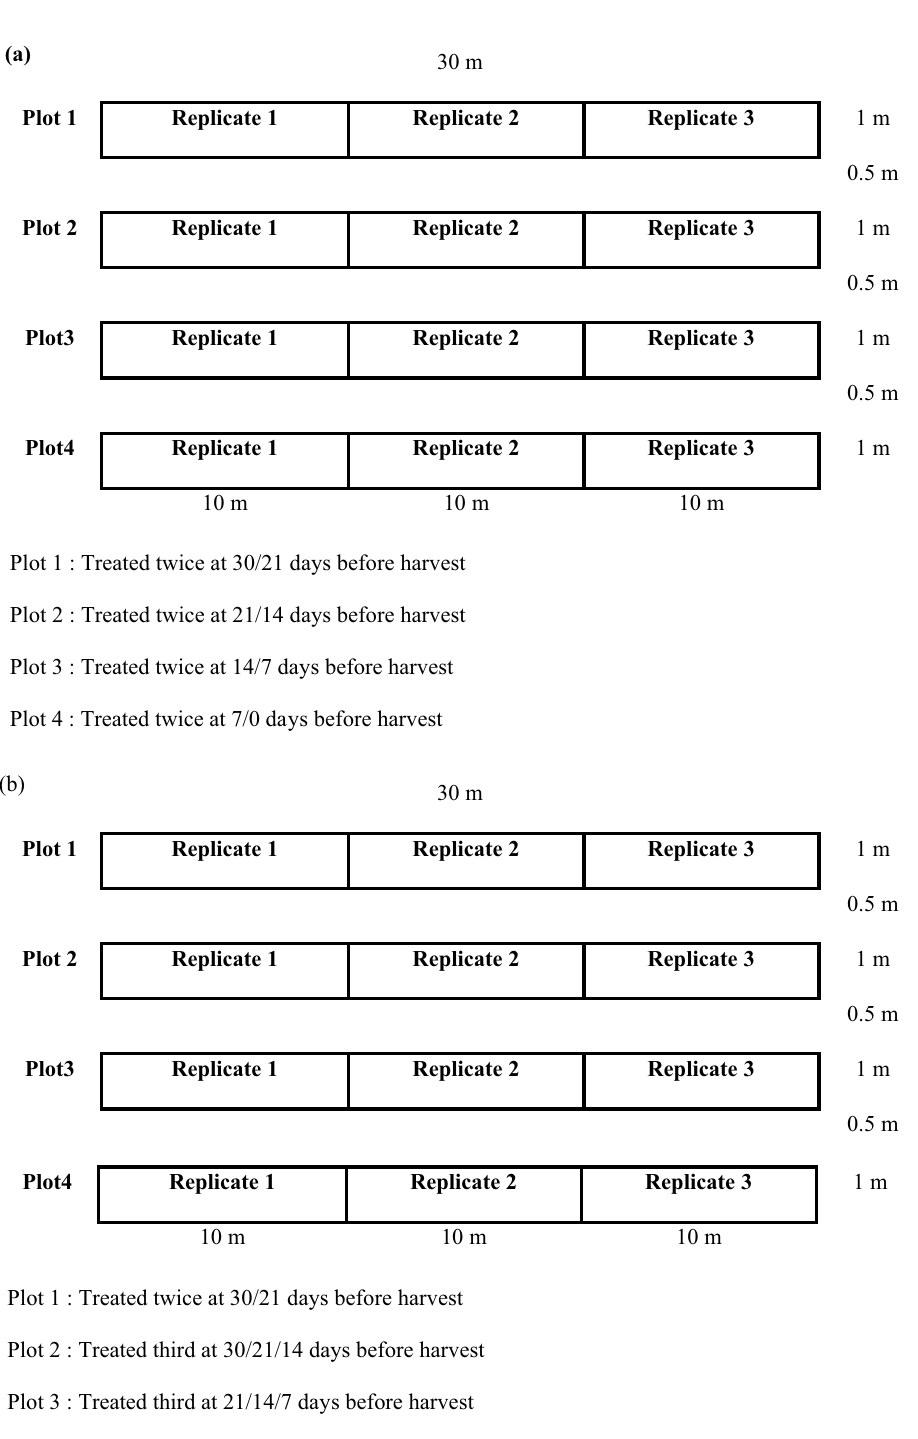
Figure 1. Experimental plots for pesticides treatment of Brussels sprout. ( a ) acephate, etofenprox, imidacloprid, indoxacarb, alpha-cypermethrin, and zeta-cypermethrin ( b ) fludioxonil and